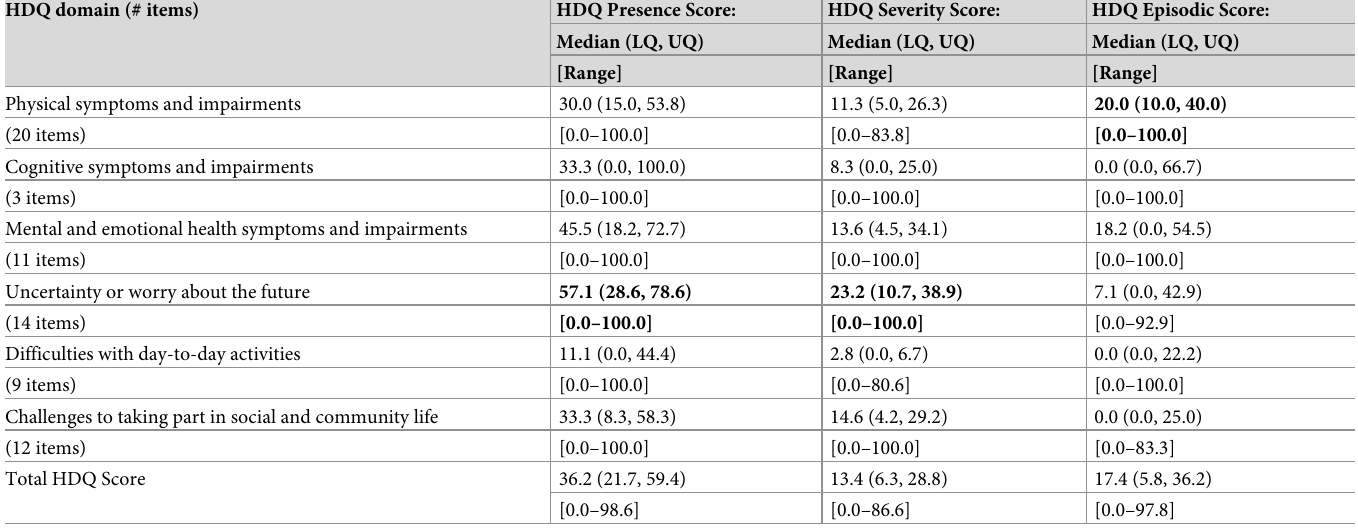
Table 2. Median HDQ domain